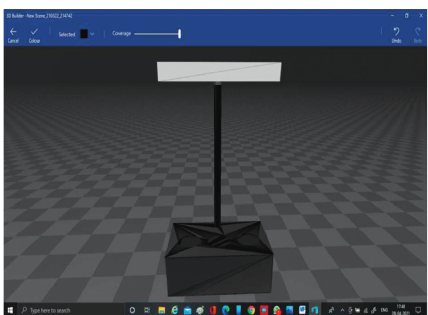
Figure 14: Side view of the body.